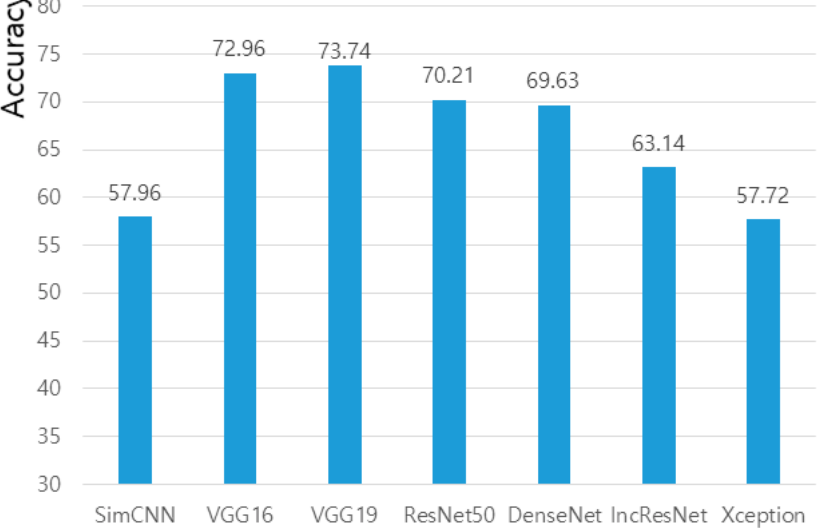
Figure 23. Comparison of the average total accuracies for the di ff erent models under transfer learning.